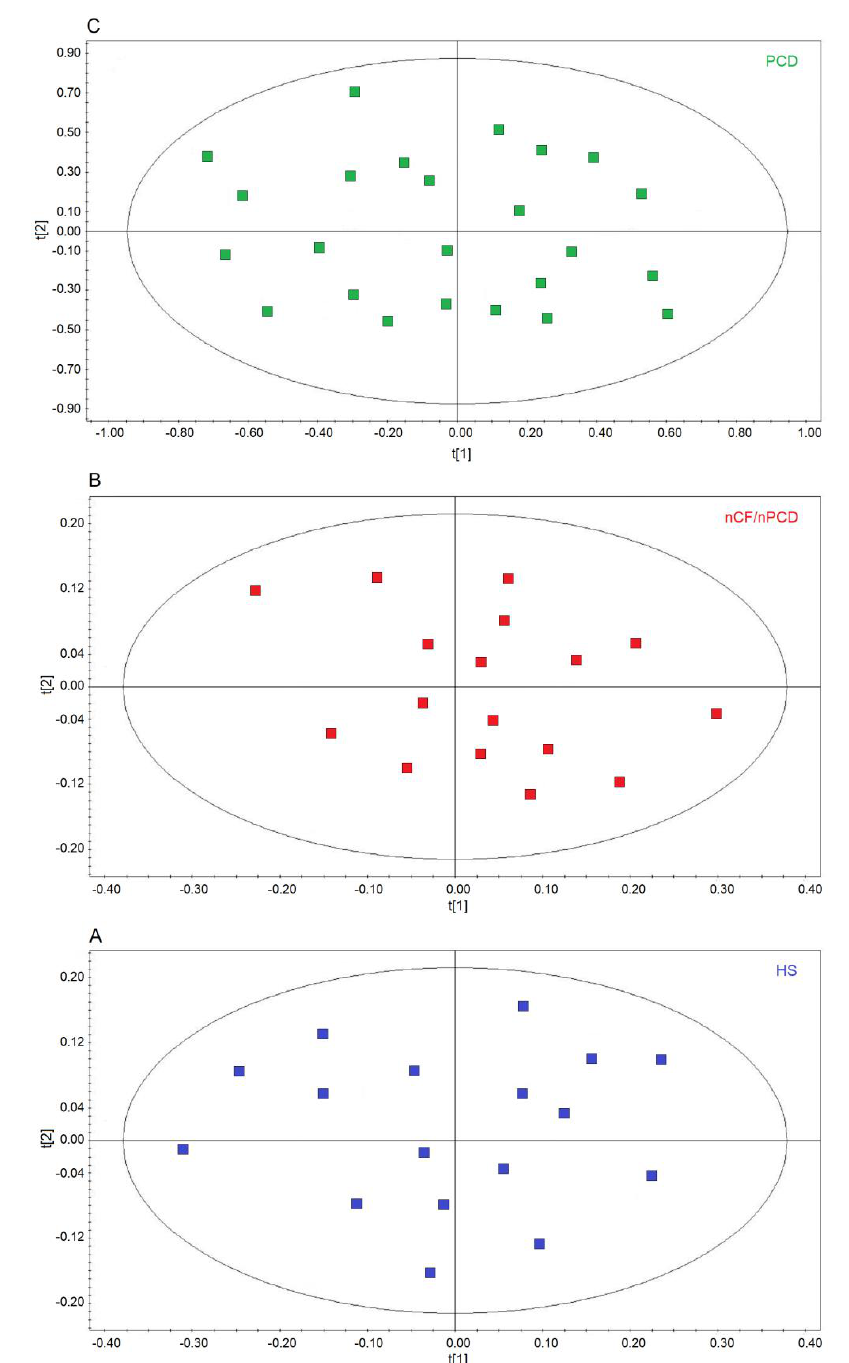
Figure 2. Principal component analysis (PCA) of EBC samples. ( A ) Scores plot relative to healthy subjects (HS, blue green squares); ( B ) scores plot for non-CF and non-PCD bronchiectasis patients (nCF / nPCD, red squares); ( C ) scores plot for PCD bronchiectasis patients (PCD, green squares). No satisfactory classification model was obtained, showing ( A ) R 2 = 0.17 and Q 2 = 0.20 ( p = 0.63) for HS; ( B ) R 2 = 0.19 and R 2 = 0.21 ( p = 0.47) for the nCF / nPCD; ( C ) R 2 = 0.23 and Q 2 = 0.29 ( p = 0.58) for PCD. The labels t[1] and t[2] along the axes represent the scores (the first two partial least squares components) of the model. The absence of subgroup clustering in all plots confirms class homogeneity.